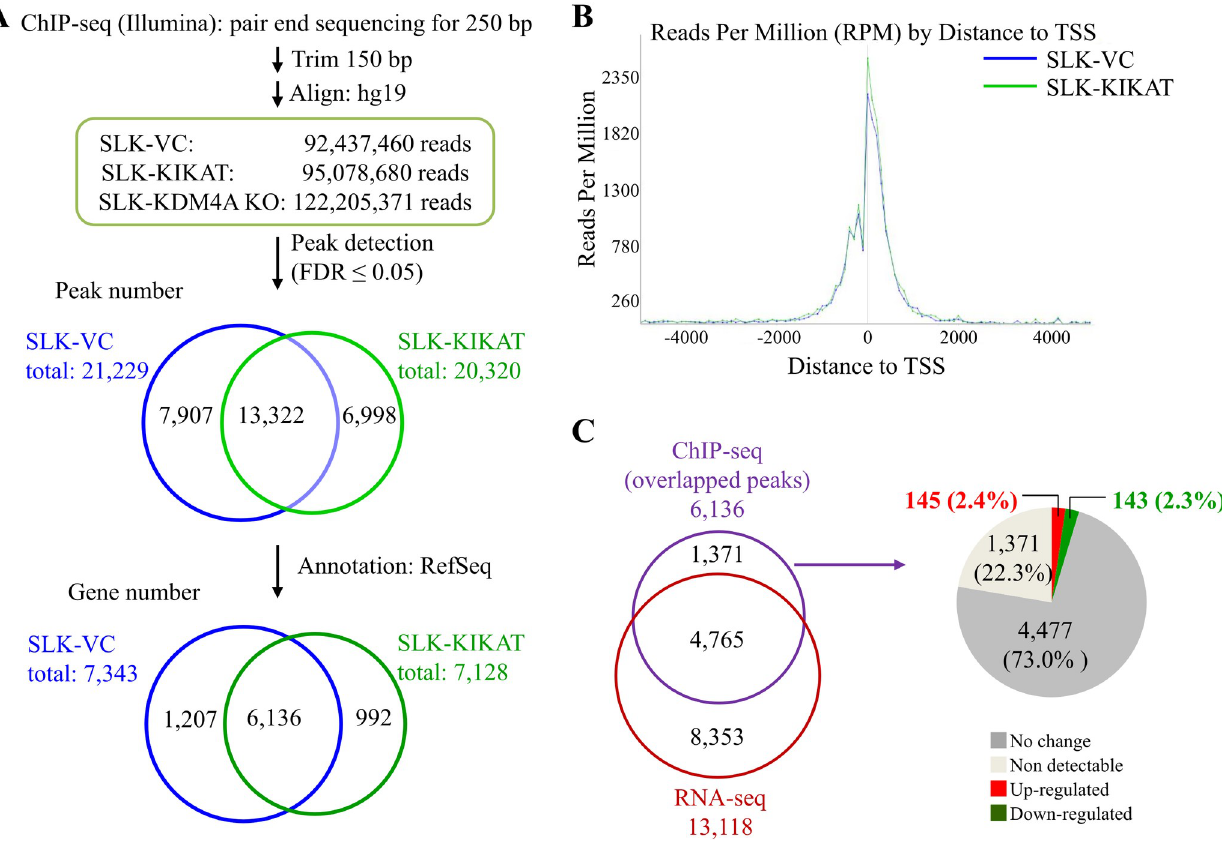
Fig 4. Genome-wide ChIP-seq analysis revealed the regulatory role of KIKAT/LINC01061 in KDM4A occupancy in SLK cells. (A) Workflow showing the identification of KDM4A ChIP-seq peaks. ChIP-seq was performed using chromatin DNA immunoprecipitated (IPed) from SLK-VC, SLK-KIKAT/ LINC01061 and SLK-KDM4A KO-VC cells by KDM4A antibody. Paired-end raw reads were trimmed and aligned to human reference genome hg19 using CLC Genomics Workbench (Qiagen Germantown, MD, USA). KDM4A ChIP-seq peaks were called using Partek Genomics Suite (Partek, MO, USA) with KDM4A KO ChIP DNA as control. Peaks with FDR � 0.05 were identified as significant KDM4A binding regions. KDM4A peaks were annotated to promoter regions (TSS ± 2 kb) based on RefSeq. Venn diagrams represent the KDM4A peaks (Middle) and potential target genes (bottom) coincide in SLK-VC and SLK-KIKAT/LINC01061. (B) Distance distribution of KDM4A peaks. (C) Venn diagram depicts the overlap of genes among RNA-seq (Fig 3C, right panel) and ChIP-seq (Fig 4A, bottom panel). Pie chart showing the numbers (percentages) of mRNAs that were up- or down-regulated more than 2-fold in SLK-KIKAT/LINC01061 when compared with